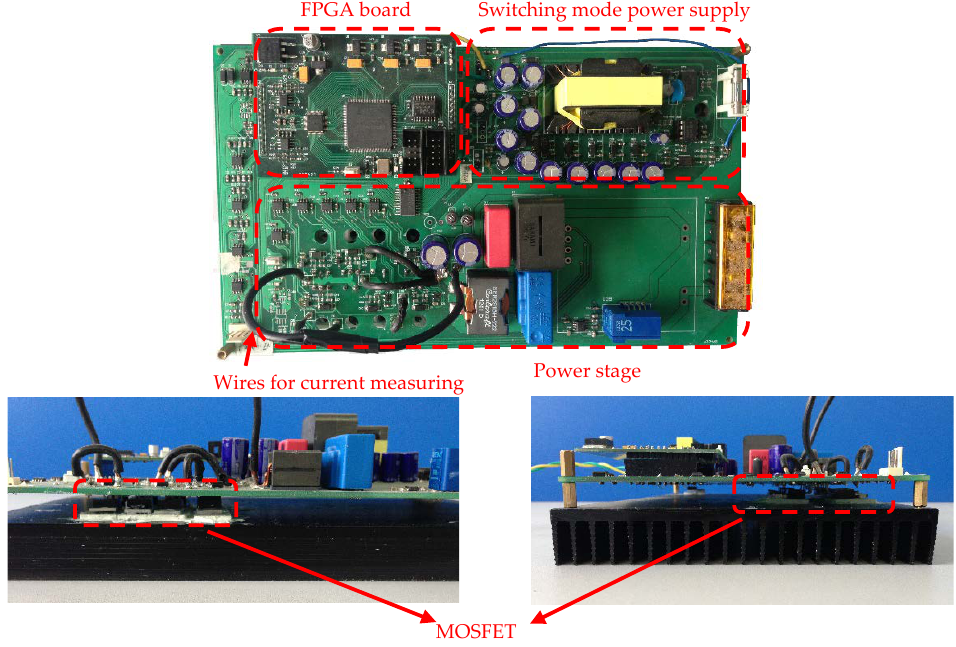
Figure 10. The photograph of the prototype.